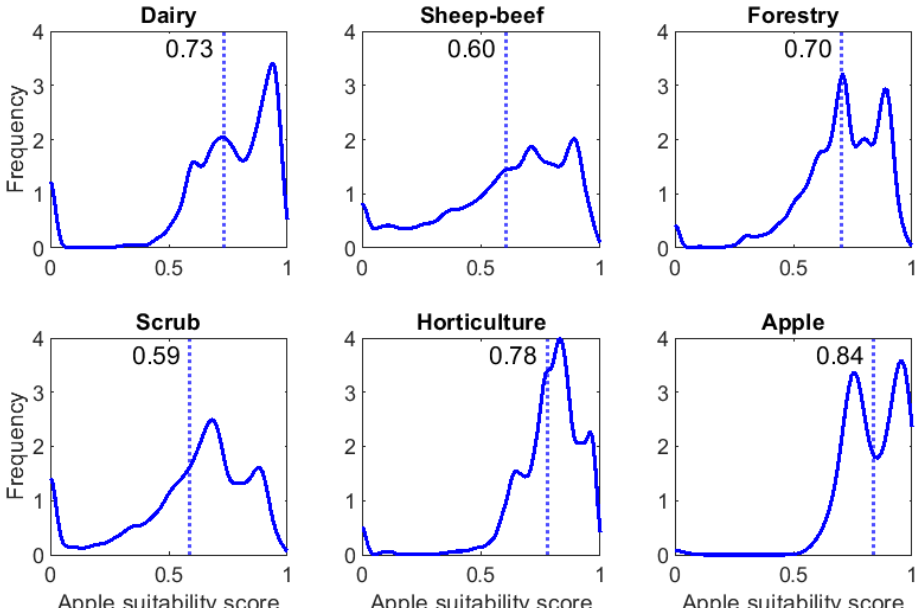
Figure 12. The frequency distribution (solid line) and mean (dotted line with value indicated) of apple